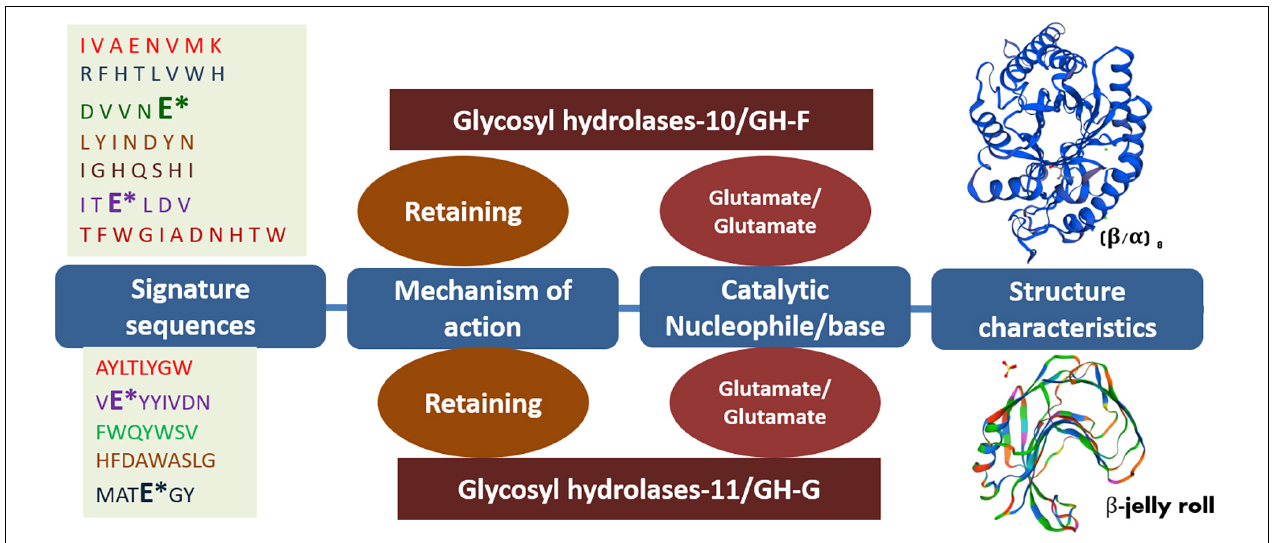
FIGURE 2 | Different features of GH-10 and GH-11 endoxylanases. Asterisk (*) represents the catalytically important glutamate residues in the putative signature sequences of respective GH-10 and GH-11 endoxylanases. The frequency of the amino acids in the signature sequences may slightly vary among the respective families while retaining 100% conservancy for catalytically important residues